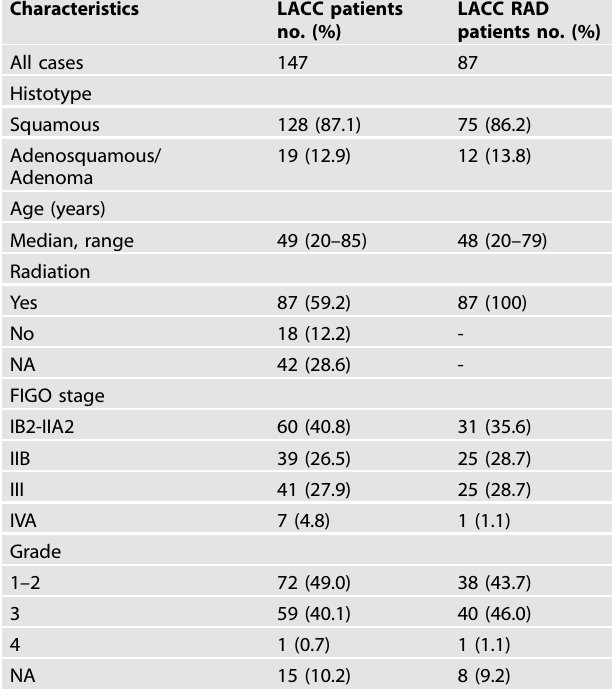
Table 1. Clinicopathological characteristics of TGCA-CESC patient cohort.